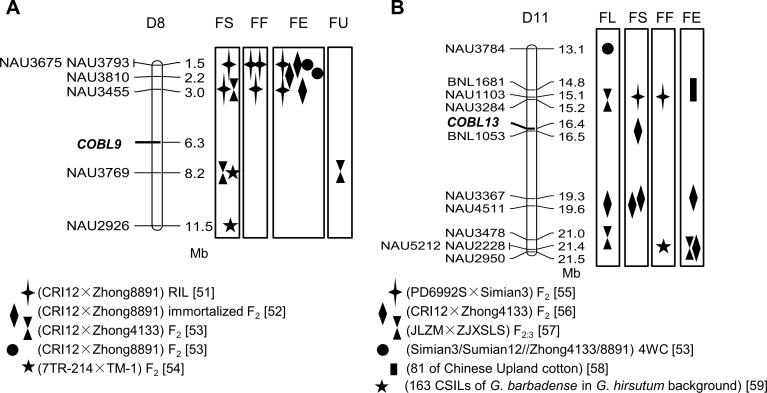
Physical integration of GhCOBL9 and GhCOBL13 with QTLs associated with fiber quality traits.Fiber quality traits included fiber length (FL), fiber strength (FS), fiber micronaire (FM), fiber elongation (FE) and fiber uniformity (FU). Different symbols represented the QTLs with the references followed.